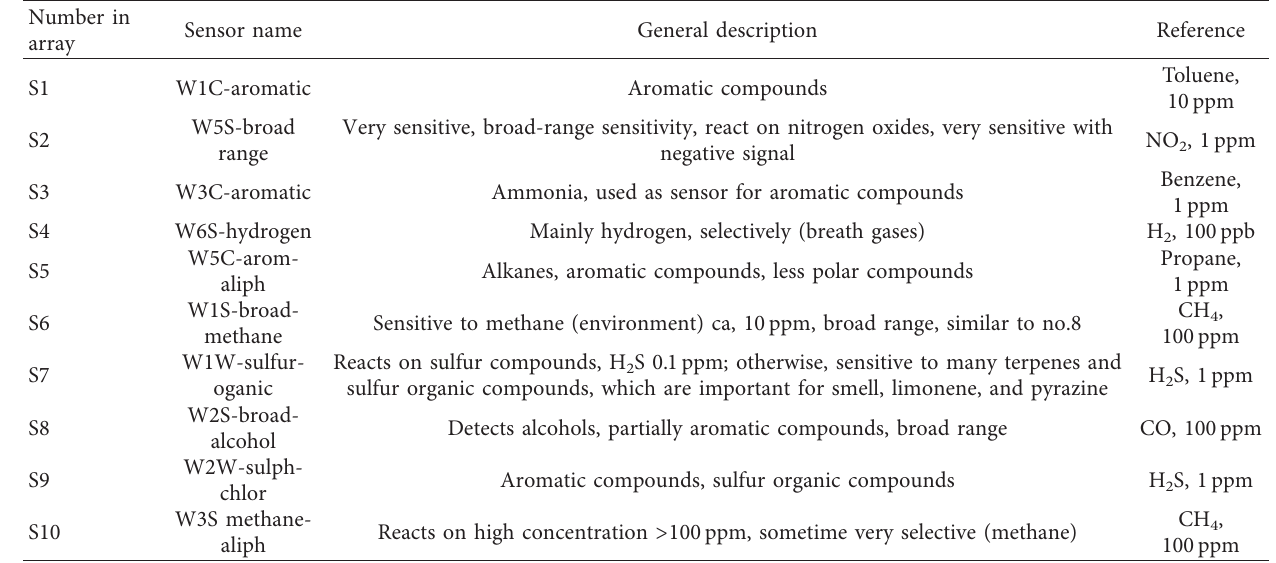
Table 2: Sensors used and their main applications in PEN 2 electronic